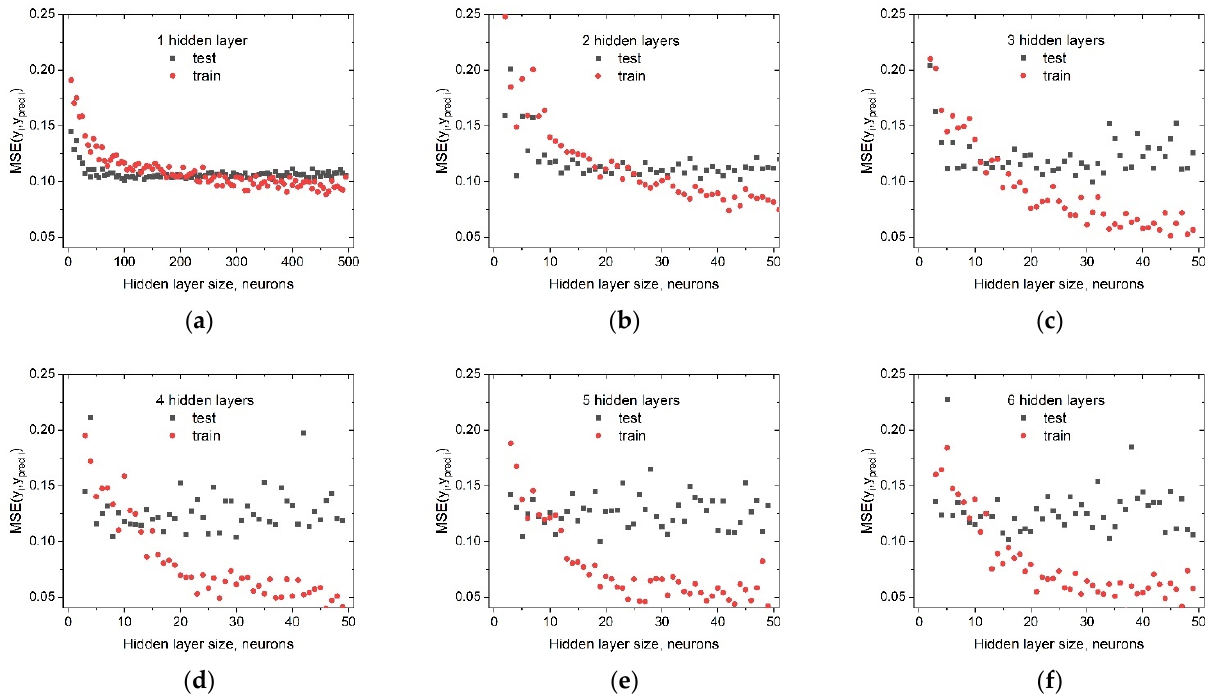
Figure 5. Determining the optimal architecture from the perspective of overfitting: MSE as a function of the number of neurons per layer for the training and test sets. Panels ( a – f ) indicates different ANN architectures—1, 2, 3, 4, 5 or 6 hidden layers, correspondingly.